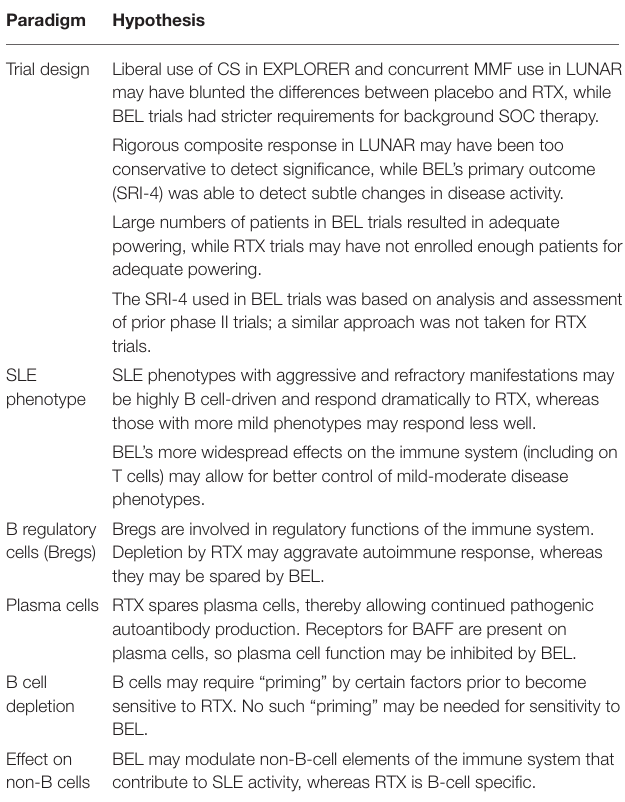
TABLE 3 | Rituximab/belimumab